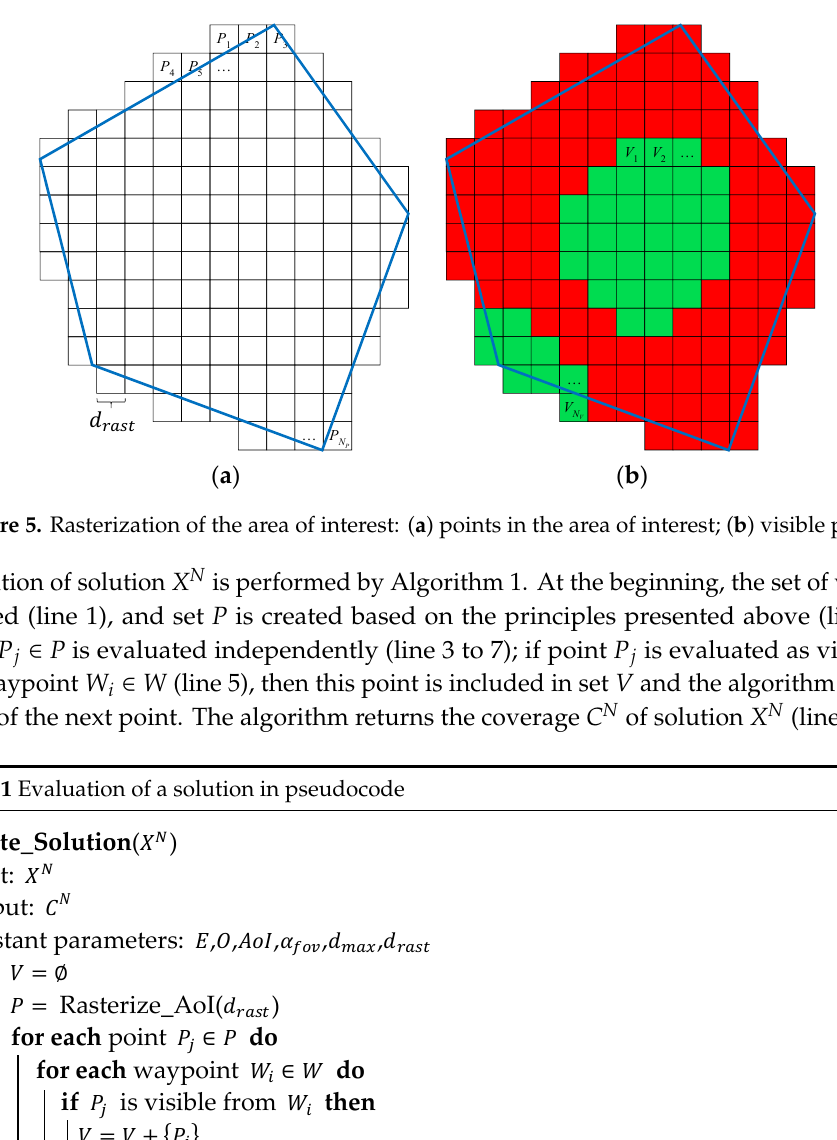
Figure 5. Rasterization of the area of interest: ( a ) points in the area of interest; ( b ) visible points.